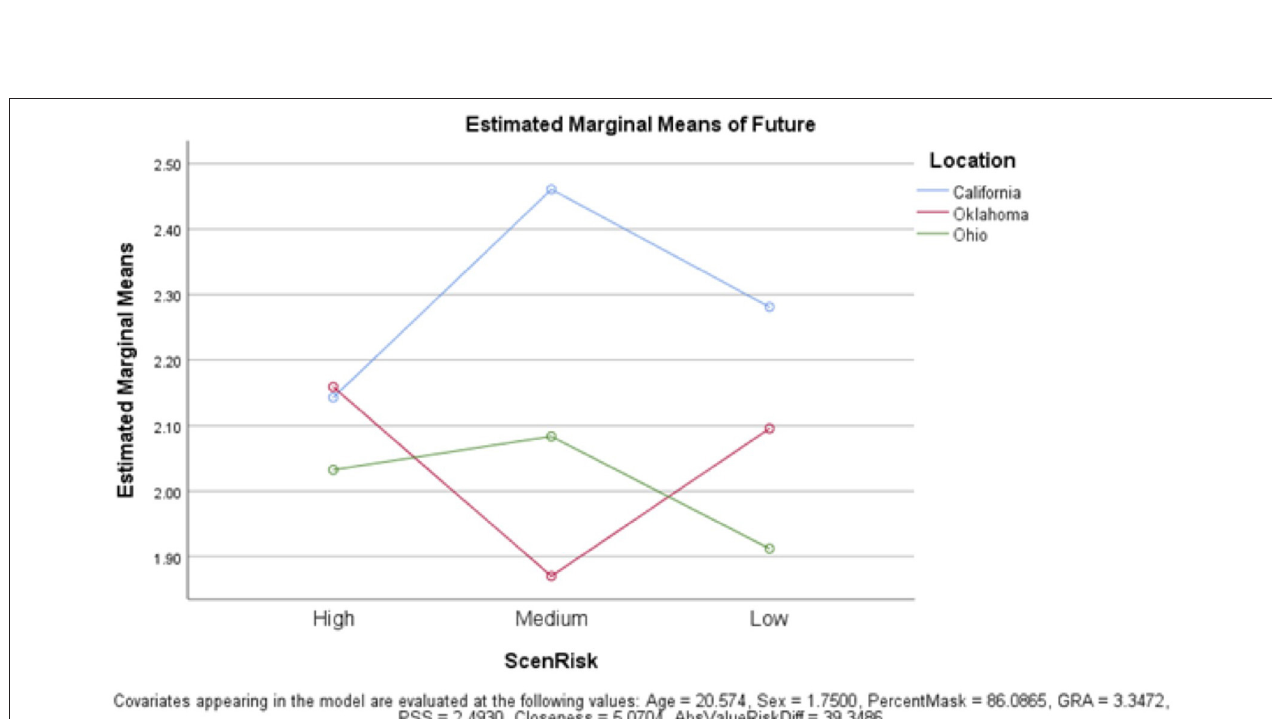
FIGURE 4 | Interaction of risk level and location of data collection to predict reported perceived future relationship implications of an event invitation refusal during the COVID-19 pandemic.